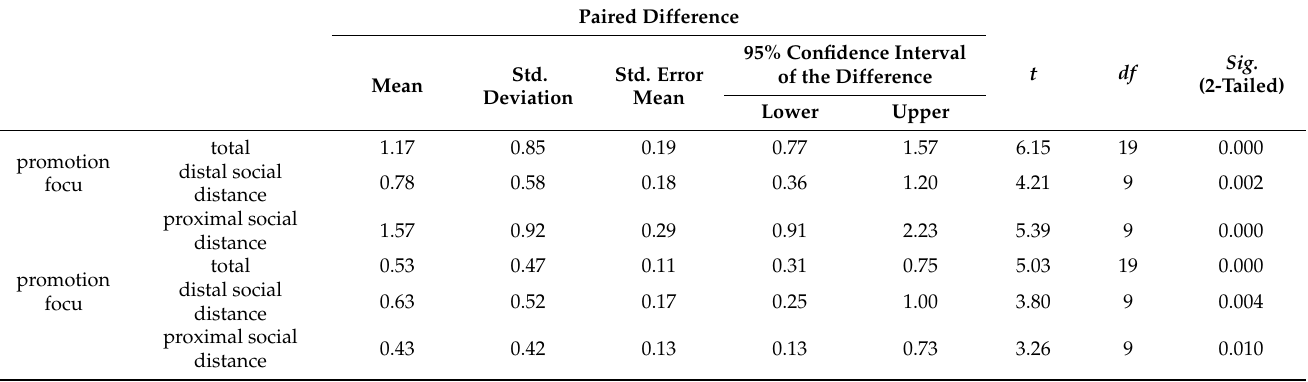
Table 2. Paired samples test (the willingness to accept information before and after